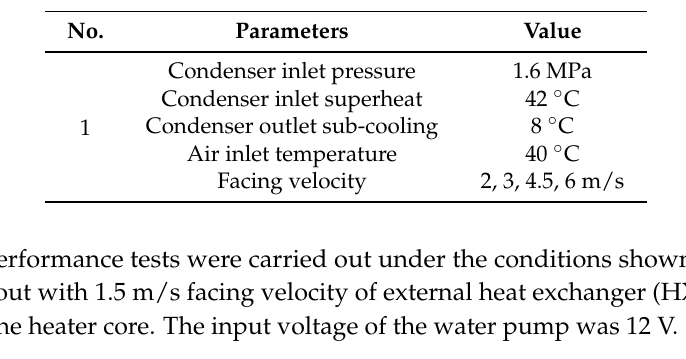
Table 4. System performance test